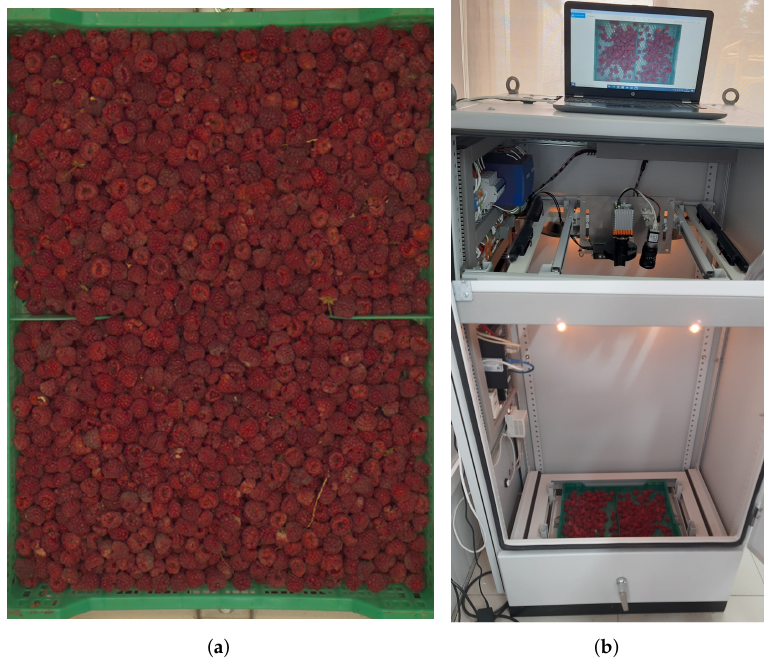
Figure 2. Raspberries and equipment. ( a ) RGB image of raspberries in a tray to be evaluated. Note that it is a sample unit of the fruit, which is uniformly distributed throughout the tray, avoiding overlap between the fruit as much as possible. ( b ) Patented device for the acquisition of the images. Observe that the tray is placed at the bottom of the device, at the top is the lighting system, and an external computer to store the